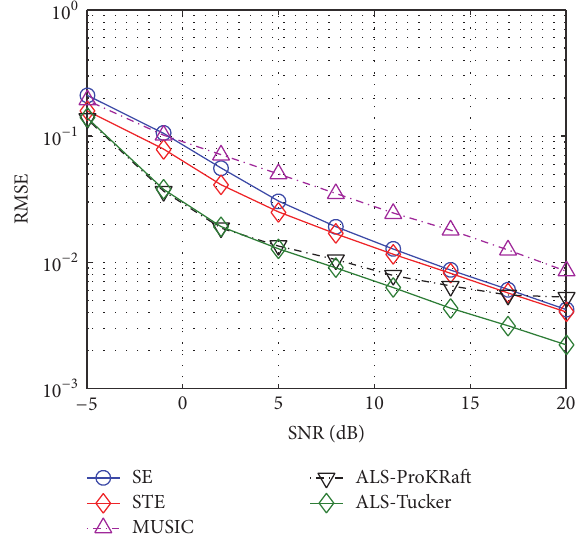
Figure 3: Total RMSE versus SNR for 𝑁 = 64 sensors, 𝐾 = 10 samples, and DoAs: {30 ∘ ,55 ∘ } and {45 ∘ , 60 ∘ } for BPSK sequences.